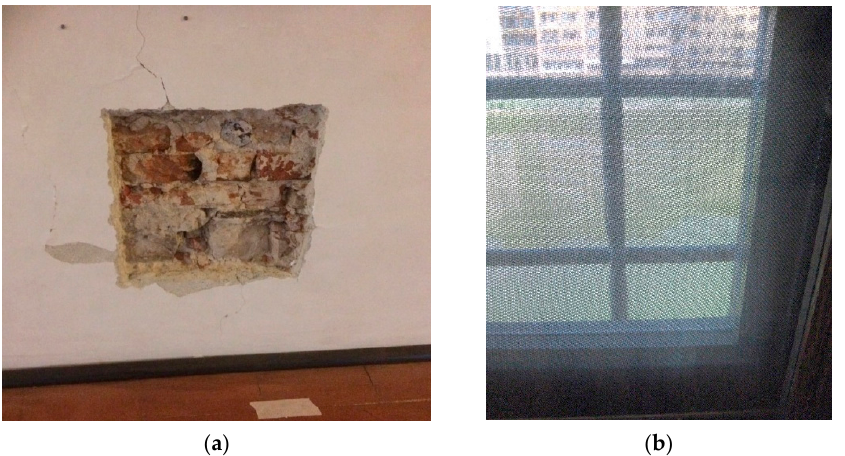
Figure 3. ( a ) View of the test performed on the external wall and ( b ) the roller shading on the external windows of the Vasari Corridor.